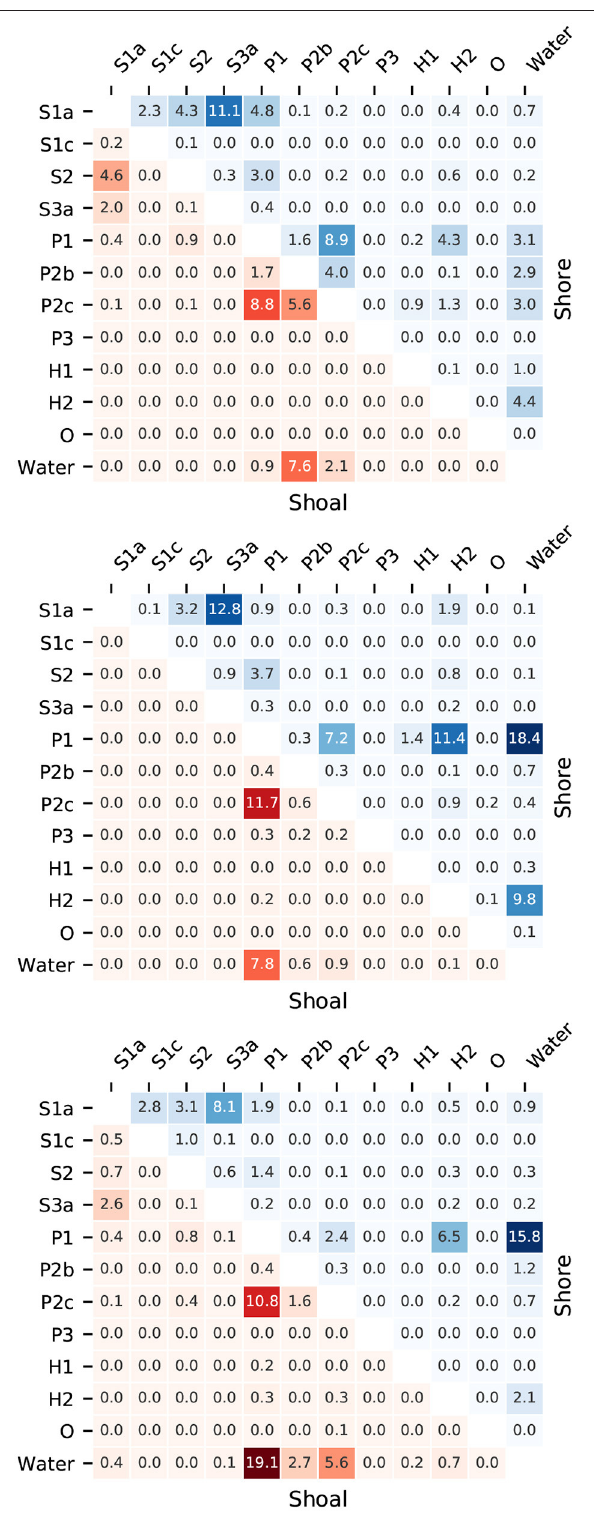
FIGURE 9 | Fraction of transition length between biogeomorphological surface classes for shore-connected areas (red) and islands and shoals (blue)